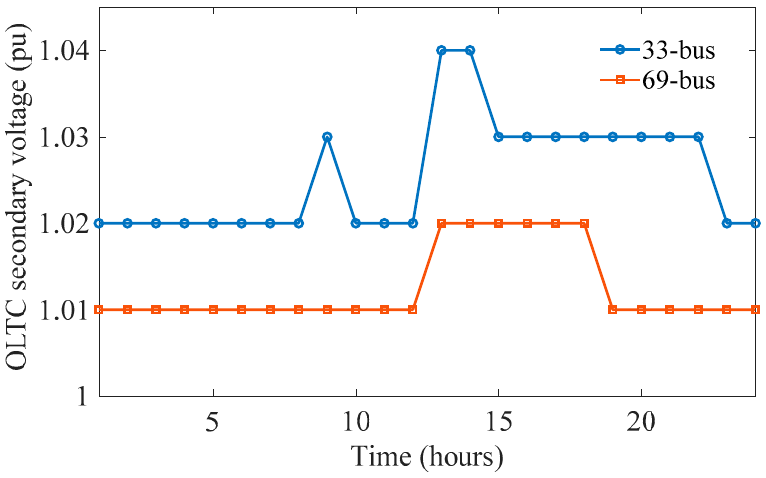
Figure 8. The optimized dispatch results of on-load tap changer (OLTC).